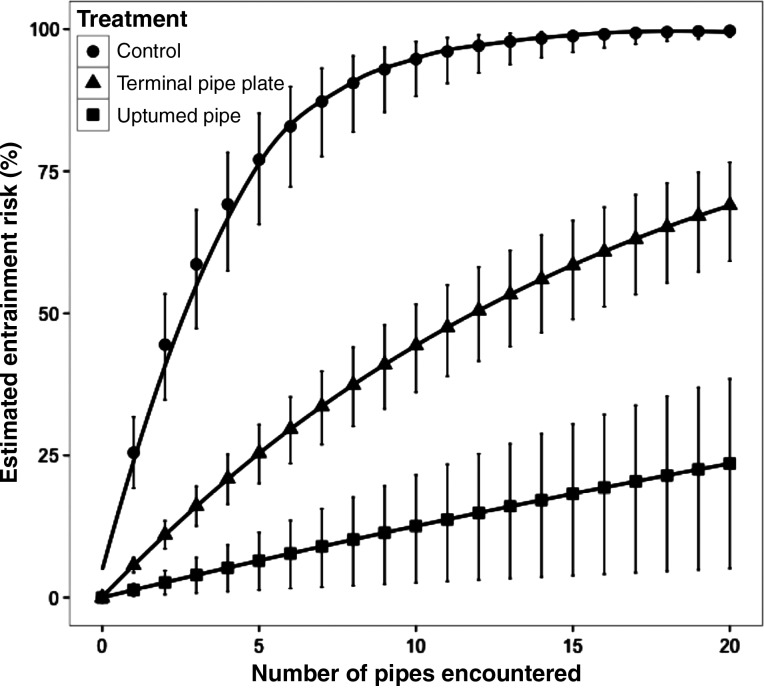
The estimated entrainment risk for juvenile green sturgeon after multiple encounters with diversion pipes. The estimated entrainment risk was projected from the entrainment risk per pipe passage (EPP) values obtained during experimental trials for the two treatments that significantly reduced EPP compared with control conditions. Vertical black bars represent 95% confidence intervals.